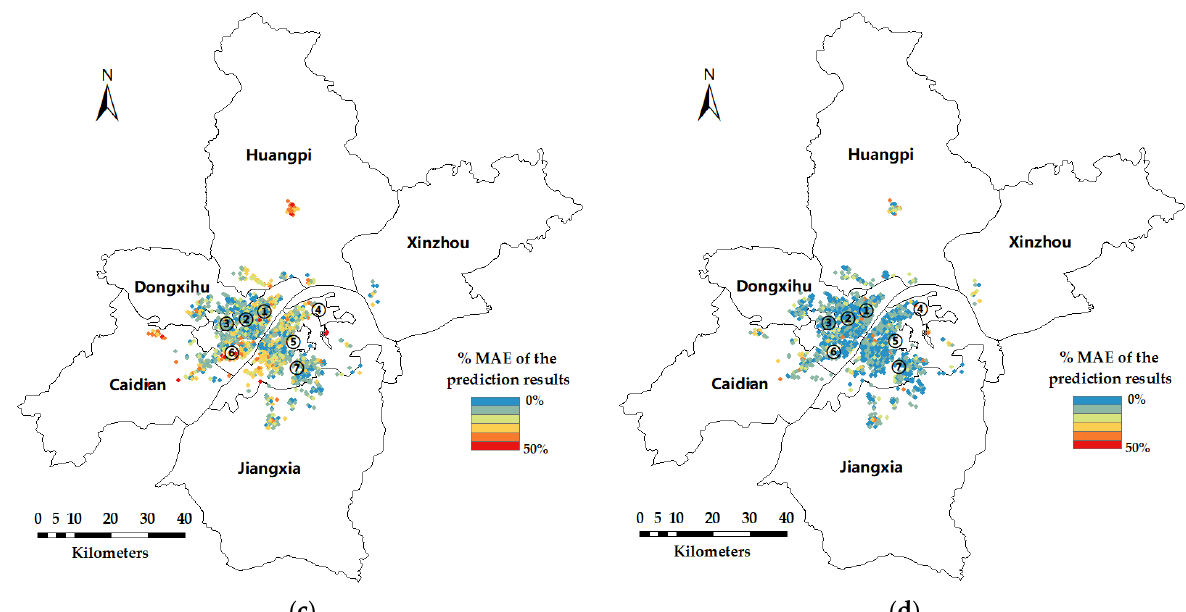
Figure 6. The difference of %MAE in predicted rental house prices of Wuhan when using the models of ( a ) GWR; ( b ) FCNN; ( c ) HPM; ( d ) FCNN-GWR. (Some of the districts: ① Jiangan, ② Jianghan, ③ Qiaokou, ④ Qingshan, ⑤ Wuchang, ⑥ Hanyang, and ⑦ Hongshan).